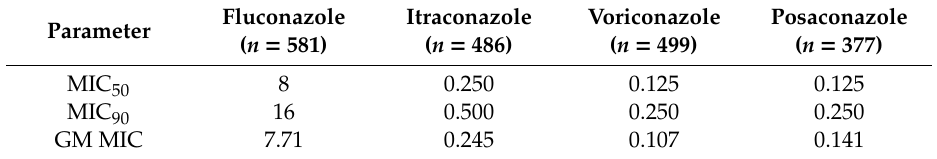
Table 1. Comparison of minimum inhibitory concentrations ( µ g / mL) of triazole antifungals. Fluconazole Itraconazole Parameter ( n = 581) ( n = 486)